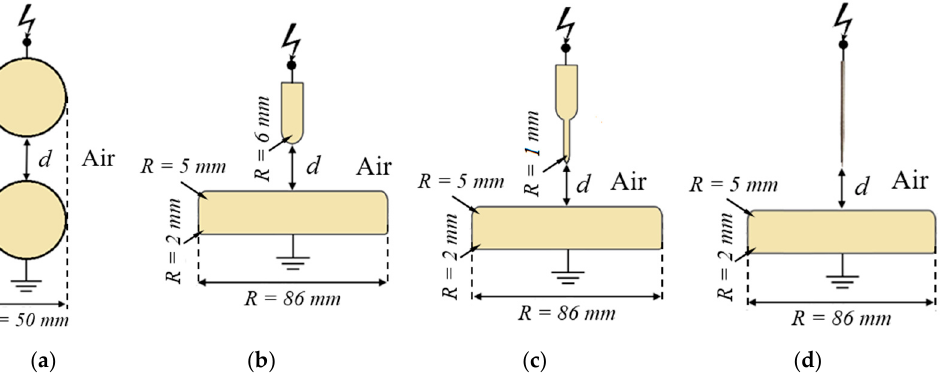
Figure 9. Electrodes used for less uniform and non-uniform electric field experiments: ( a ) sphere– sphere; ( b ) rod (R = 6 mm)–plane; ( c ) rod (R = 1 mm)–plane; ( d ) needle–plane.